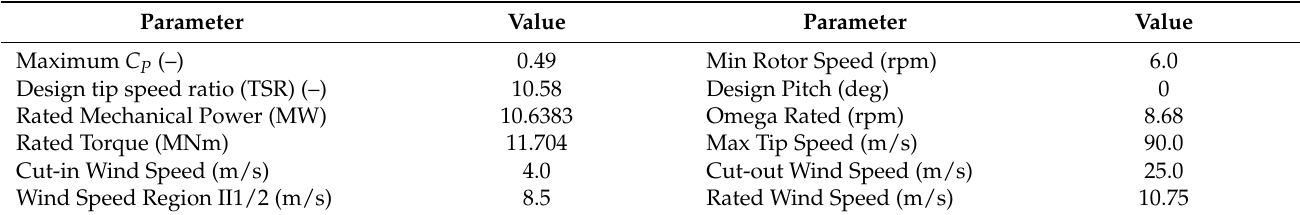
Table 2. Operational summary of the IEA 10-MW